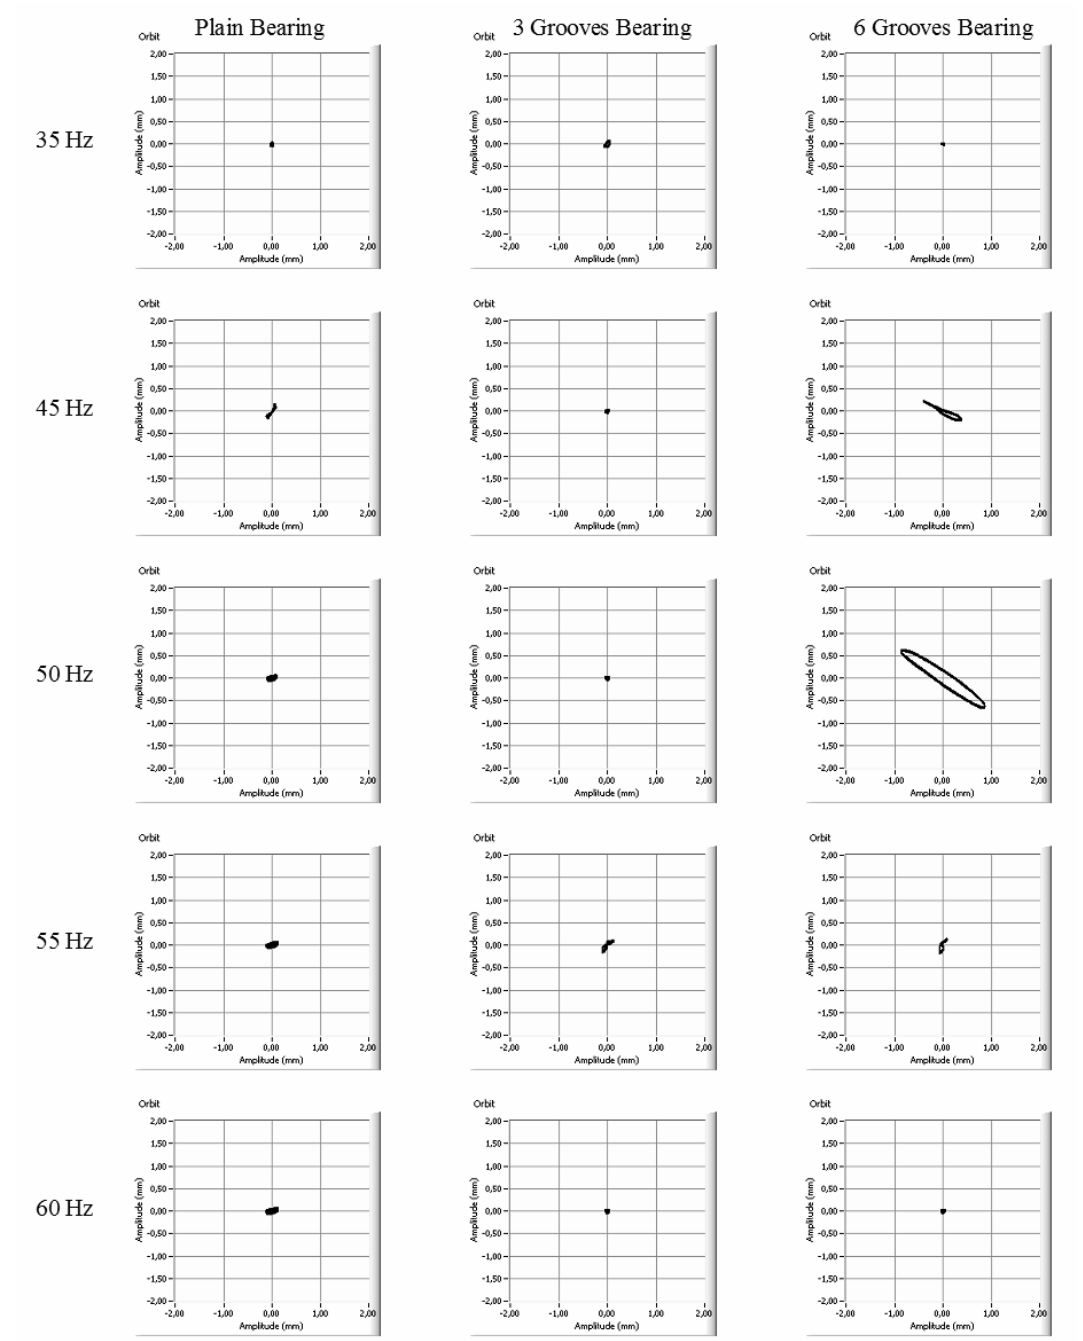
Fig. 9. Results – Orbit